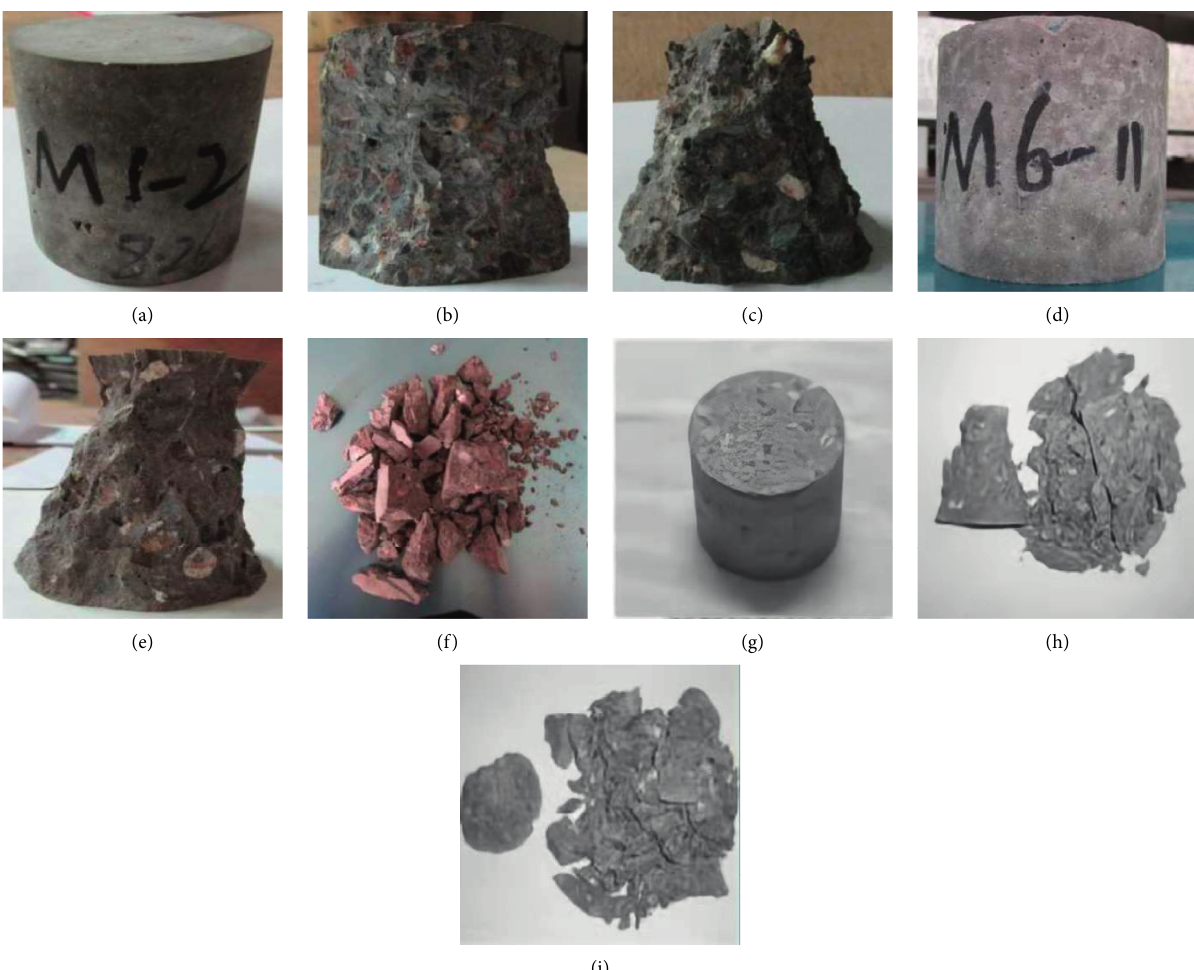
Figure 4: Destruction results of concrete specimens under different impact velocities (74mm diameter, 70mm height cylinder). M1: (a) 5m/s, (b) 17 m/s, and (c) 22 m/s. M6: (d) 5m/s, (e) 18m/s, and (f) 26 m/s. OC: (g) 5 m/s, (h) 10m/s, and (i)